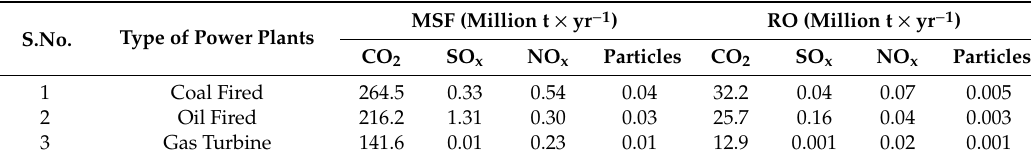
Table 6. Pollutants emission levels for powering Mult-Stage Flash (MSF) and Reverse Osmosis (RO) plants